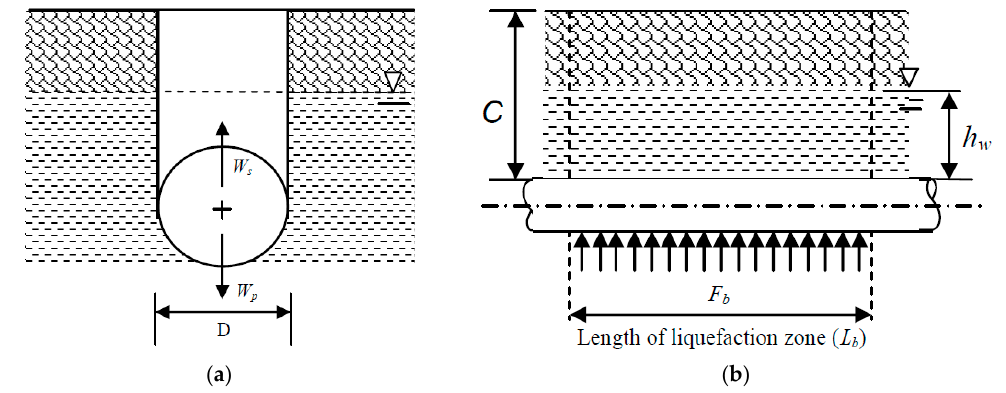
Figure 1. Buoyancy load acting on the pipeline [26] ( a ) Cross section of the pipeline showing the forces acting on it due to buoyancy; ( b ) Longitudinal section of the pipeline showing the forces acting on it due to buoyancy.